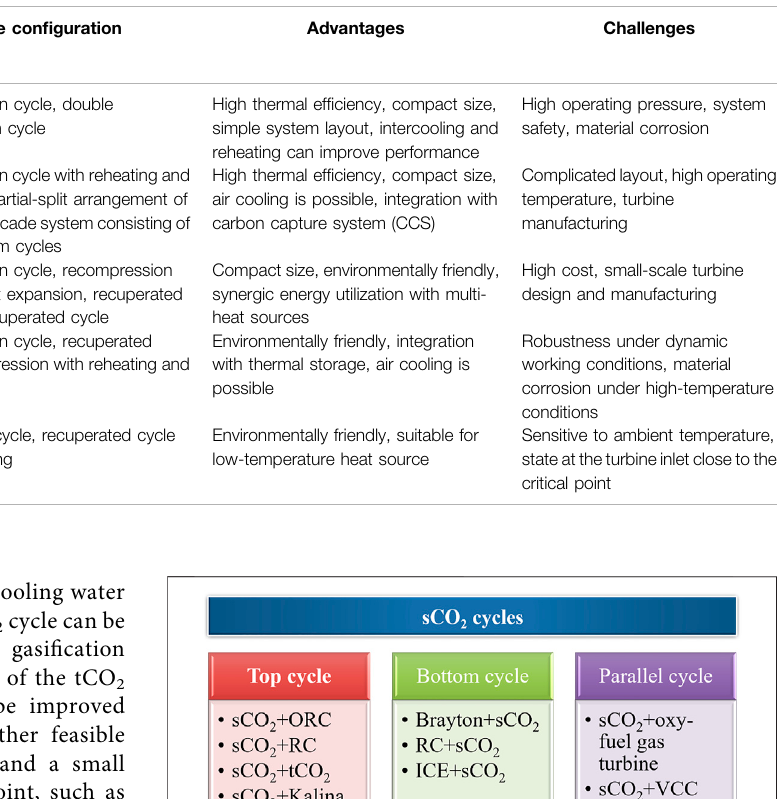
TABLE 8 | Characteristics of sCO 2 cycles for different applications.